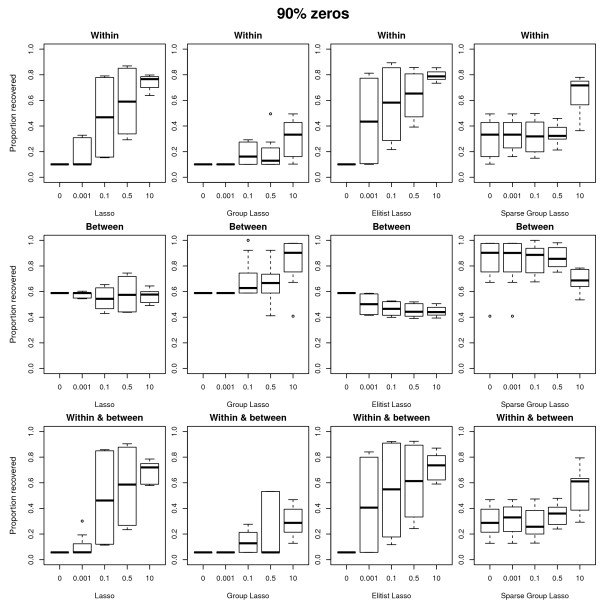
Boxplots of the proportion of recovered variables: 90 percent of true zeros. Boxplots of the proportion of variables correctly classified (selected versus dropped) in function of the value of the tuning parameters. Case with 90 percent of the variables dropped. The different panels refer to the different combinations of structure in the variable selection (from top to bottom: within blocks, between blocks, within and between blocks) and of sparseness approach (from left to right: lasso, group lasso, Elitist lasso, and sparse group lasso). The panels referring to the sparse group lasso are with varying values for the lasso tuning parameter and with the group lasso tuning parameter fixed at f = 10.